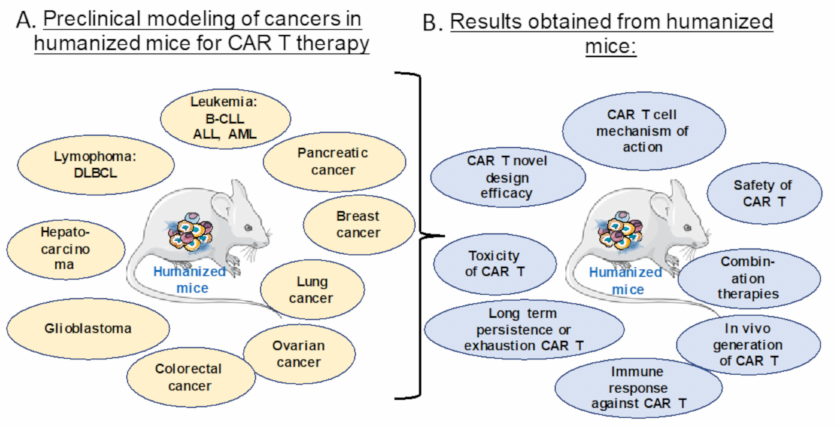
Figure 4. Preclinical modeling of CAR T Cell therapy in humanized cancer mice models. ( A ) Di ff erent humanized mice models for preclinical modeling of di ff erent malignancies. ( B ) The relevant preclinical data for CAR T cell treatment obtained for the indications in ( A